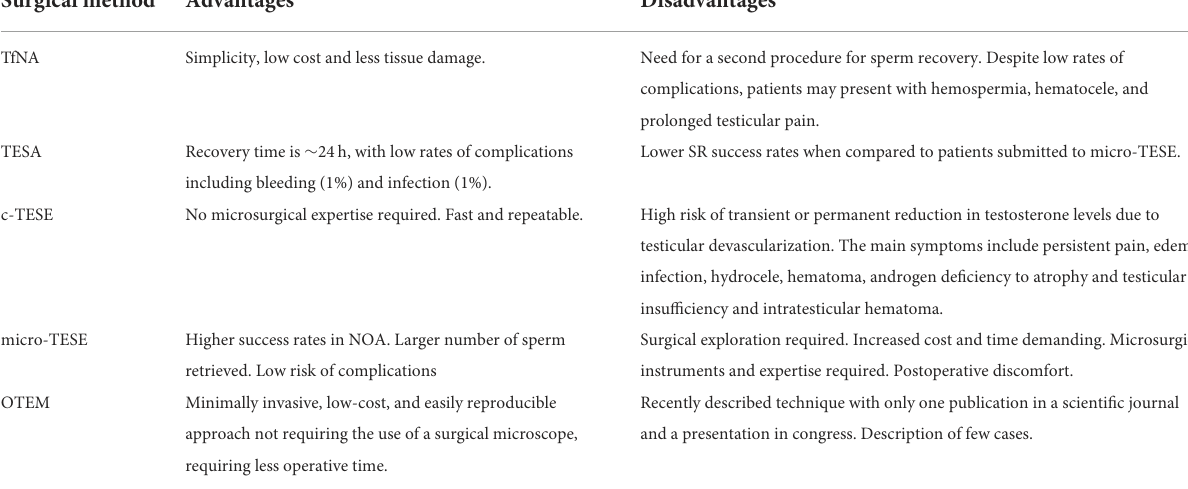
TABLE 1 Advantages and disadvantages of each surgical method. Surgical